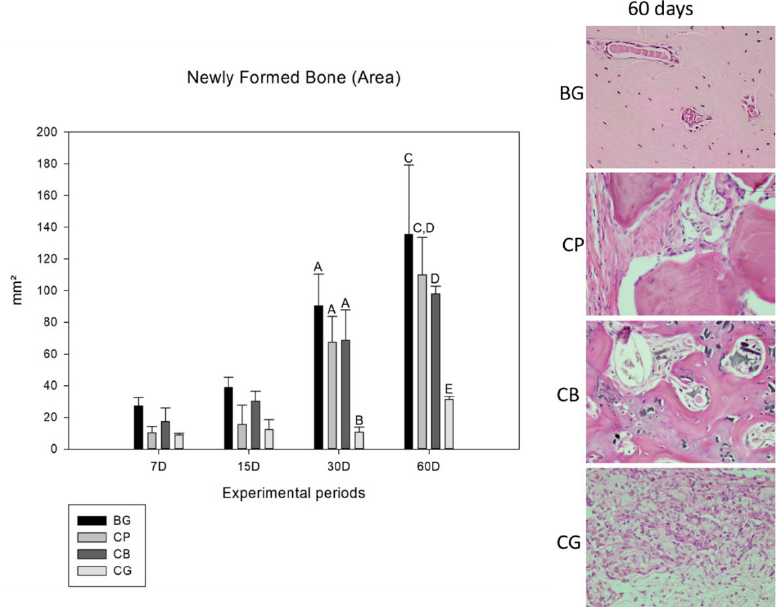
Figure 1. Comparative graph of means and standard deviation of the area of newly formed bone of all groups (BG, CP, CB and CG) for the experimental periods of 7, 15, 30 and 60 days. The capital letters A and B show a statistical difference ( p < 0.001) between the groups at 30 and C, D, E a statistical difference ( p < 0.013 for C to D and p < 0.001 for C to E and D to E) at 60 days. The 7- and 15-day experimental periods show no statistical difference between the analyzed groups. The photomicrographs at 60 days demonstrate the bone neoformation in the center of the defect for BG, CP and CB groups.